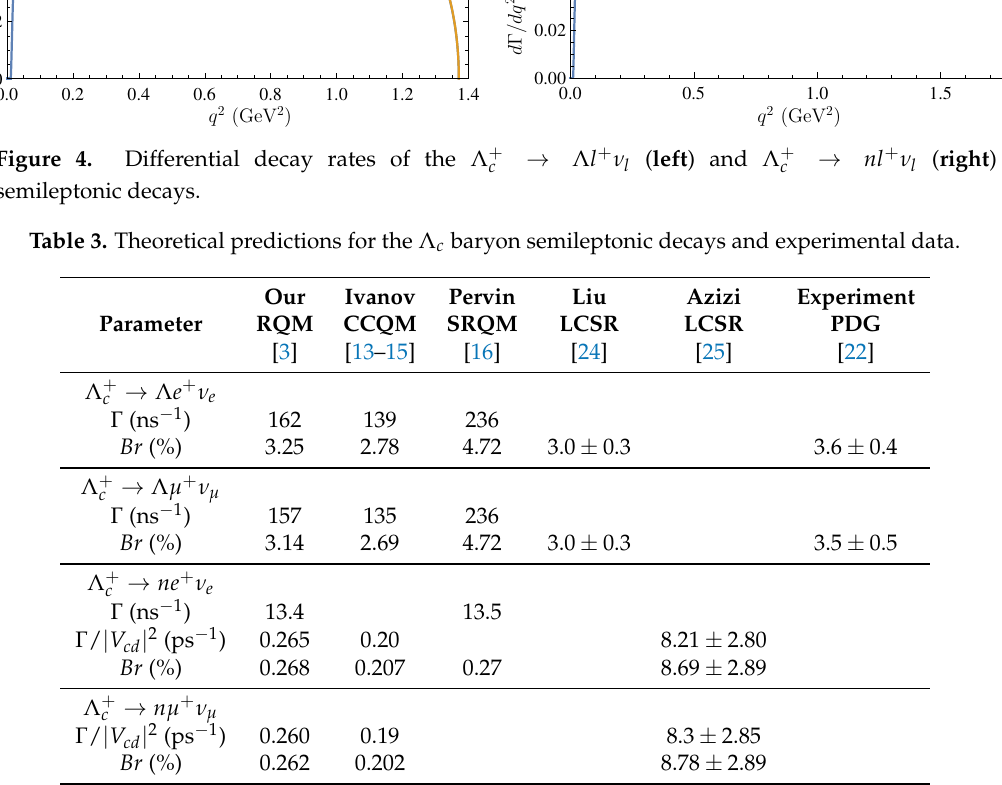
Table 4. The light-front quark model is used for the weak decay form factor and branching